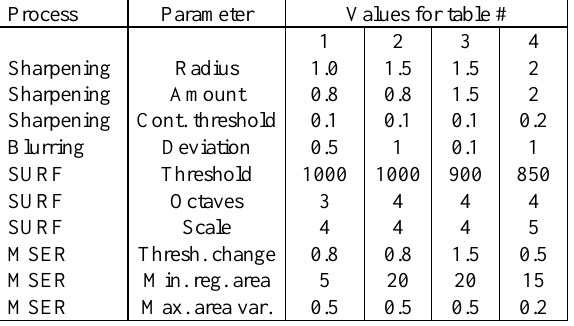
Table 1. Implemented processes and their parameter values